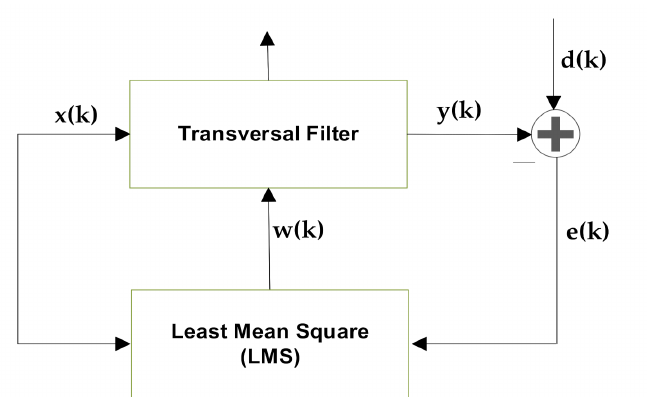
Figure 2. Block diagram and mathematical explanation of the implementation of the Least Mean Square (LMS) algorithm using a Finite Impulse Response (FIR)